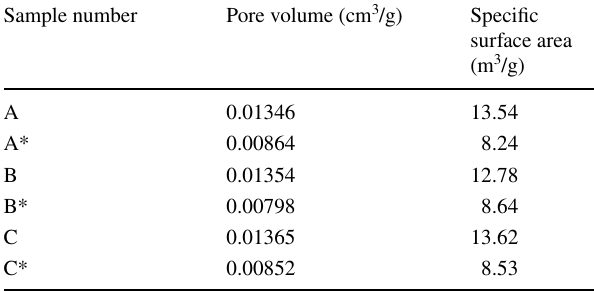
Table 6 Pore characteristics of